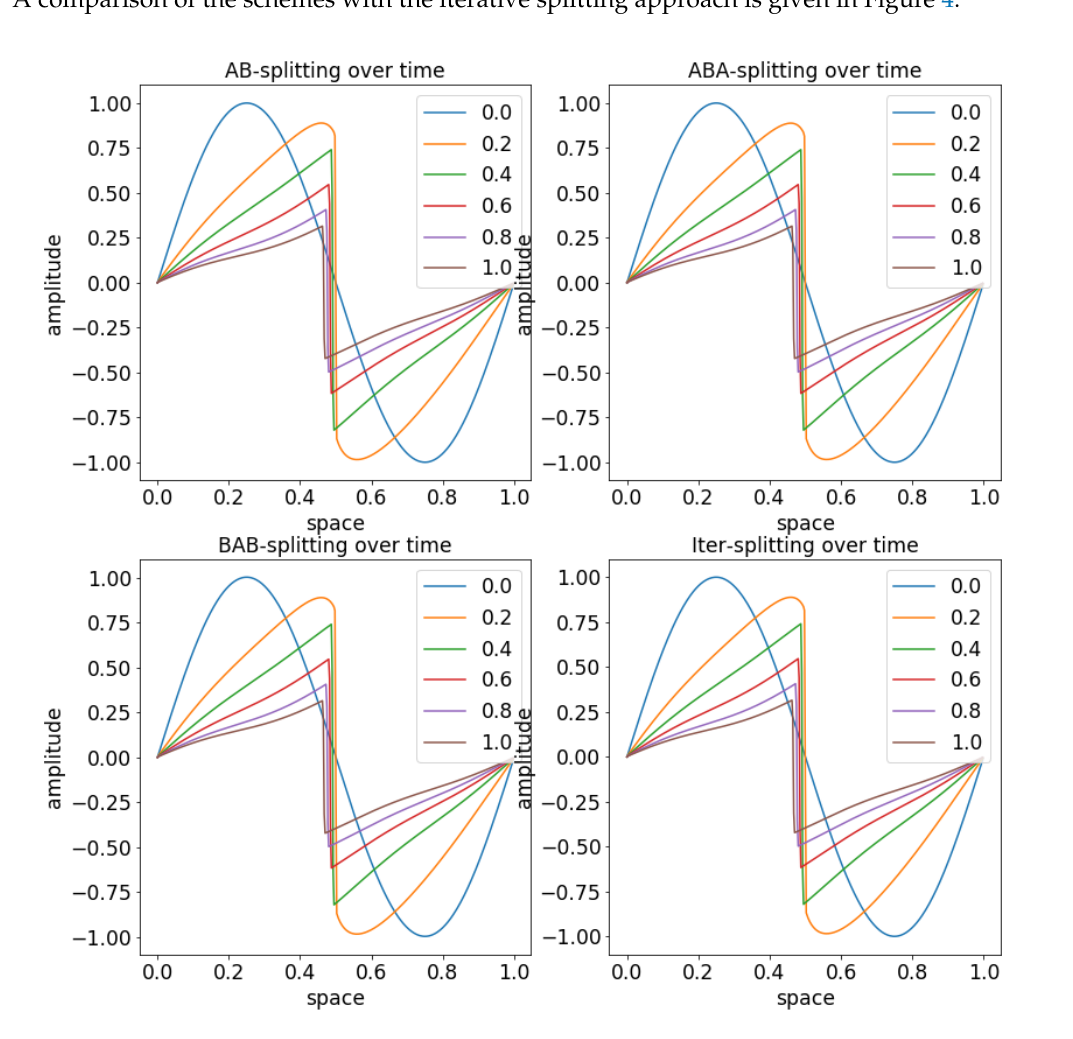
Figure 4. For the experiments, we have applied the variance σ ( c ) = sin ( 2 π x ) c and the initial condition c 0 = sin ( 2 π x ) . We apply different time-steps, means we start with n = 0, which is the 0.0-line and the highest number of time-step with n = 500, which is the 1.0-line. Therefore, we see the influence of the stochastic reaction term, which deformed the initial-solutions. In the left-hand upper panel, we present the solutions of the AB-spitting approach with the different time-steps. In the right-hand upper panel, we present the solutions of the ABA-spitting approach with the different time-steps. In the left-hand lower panel, we present the solutionss of the BAB-spitting approach with the different time-steps. In the right-hand lower panel, we present the solutions of the iterative-spitting approach with the different